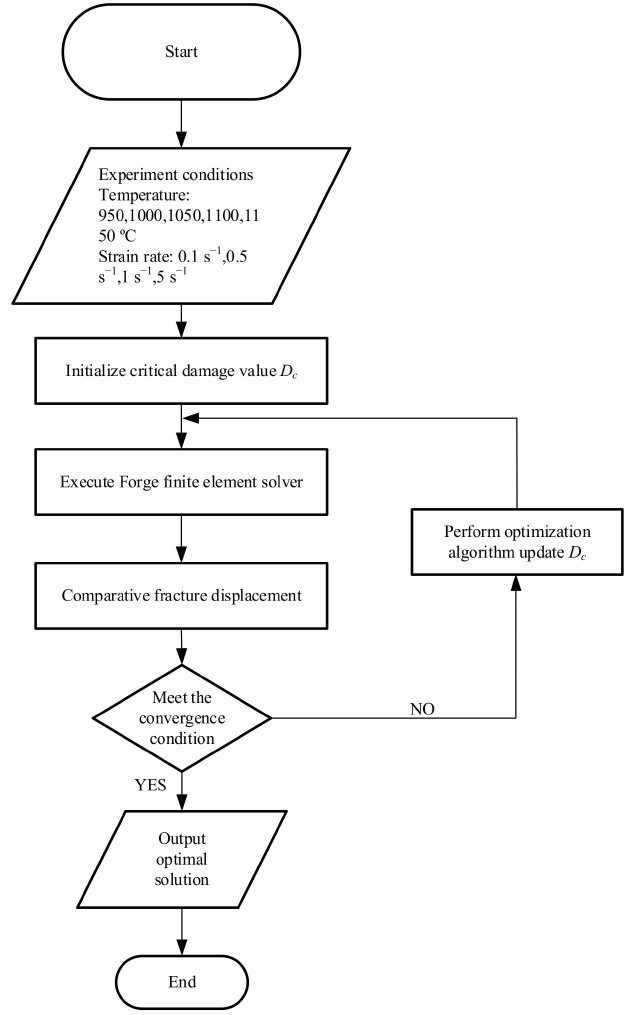
Figure 6. Reverse method flow chart.